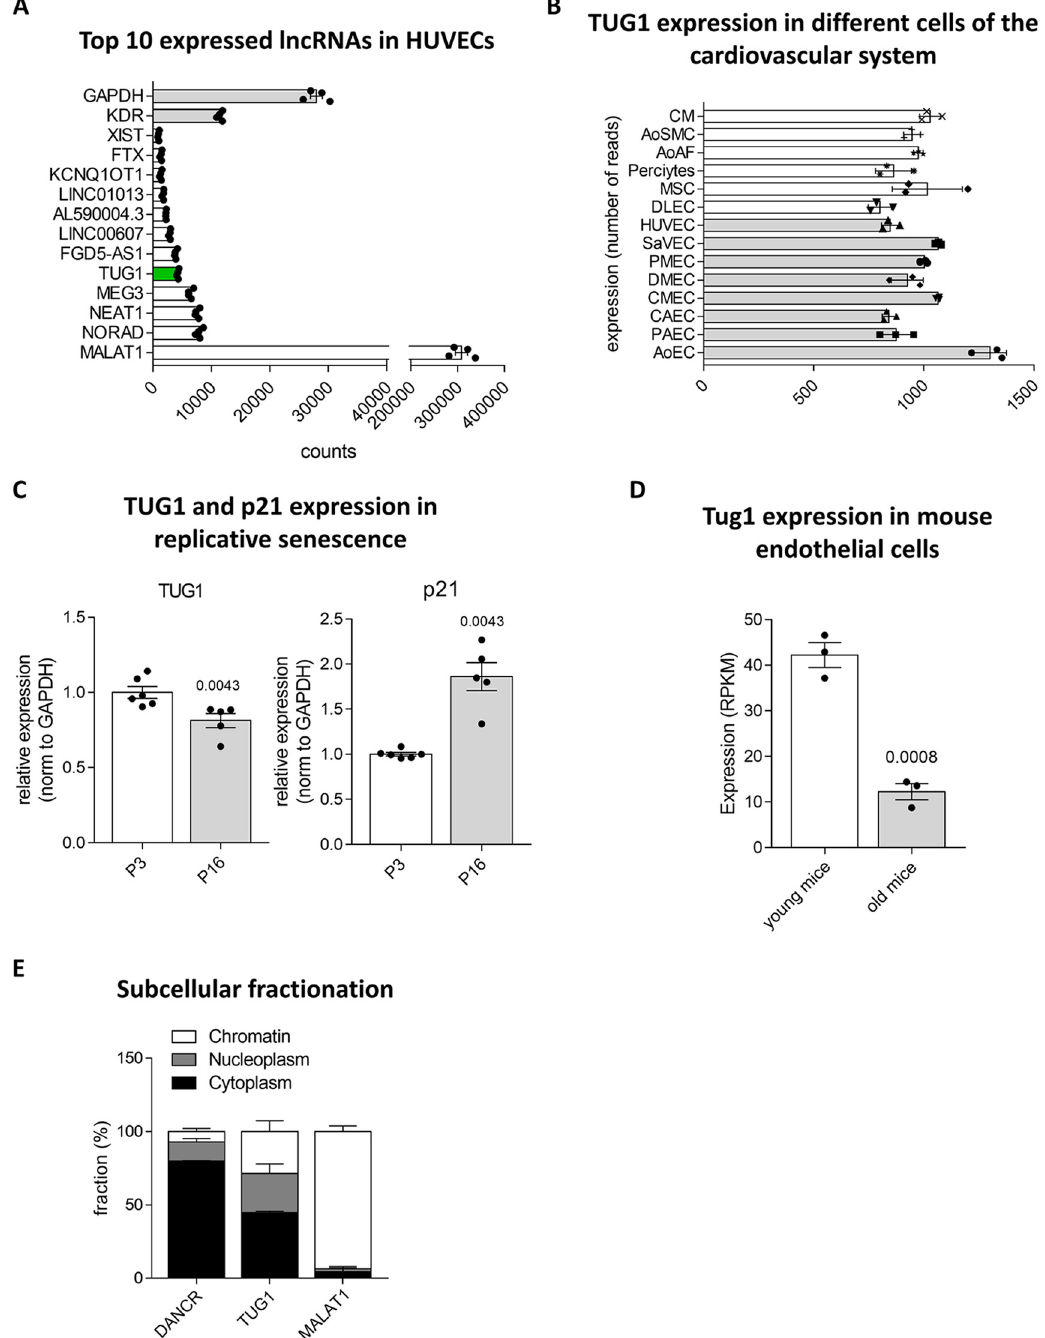
Fig 1. TUG1 is highly expressed in endothelial cells and regulated by aging in human and mouse. (A) Top 10 expressed lncRNAs based on transcript counts from HUVEC bulk RNA sequencing data (n = 4). TUG1 is highlighted in green. Glyceraldehyde 3-phosphate dehydrogenase ( GAPDH ) and Kinase Insert Domain Receptor ( KDR ) were used as controls. (B) RNA expression levels of TUG1 in different human cell types of the cardiovascular system (n = 3). Vascular ECs are highlighted by grey bars. AoEC: Aortic ECs, PAEC: Pulmonary Artery ECs, CAEC: Coronary Artery ECs, CMEC: Cardiac Microvascular ECs, DMEC: Dermal Microvascular ECs, PMVEC: Pulmonary Microvascular ECs, SaVEC: Saphenous Vein ECs, HUVEC: Human Umbilical Vein ECs, DLEC: Dermal Lymphatic ECs, MSC: Mesenchymal Stem Cells, AoAF: Aortic Arterial Fibroblasts, AoSMC: Aortic Smooth Muscle Cells, CM: Cardiomyocytes (C) TUG1 expression levels in low (P3) vs. high (P16) passage HUVECs as determined by RT-qPCR. Expression is relative to GAPDH (n = 5–6; SEM; Mann-Whitney-test). (D) Tug1 expression from bulk